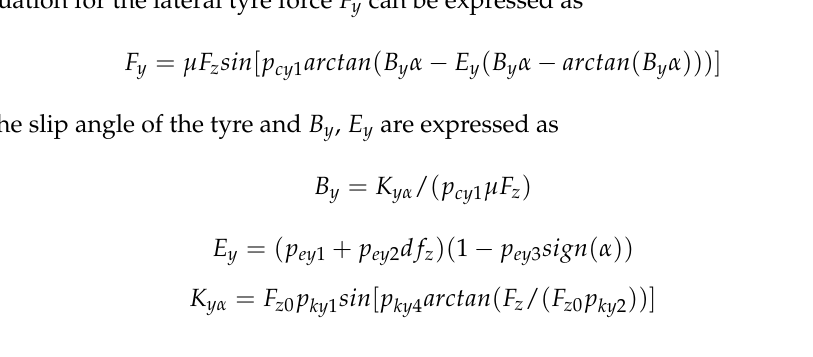
Table 2. Tyre force coefficients.